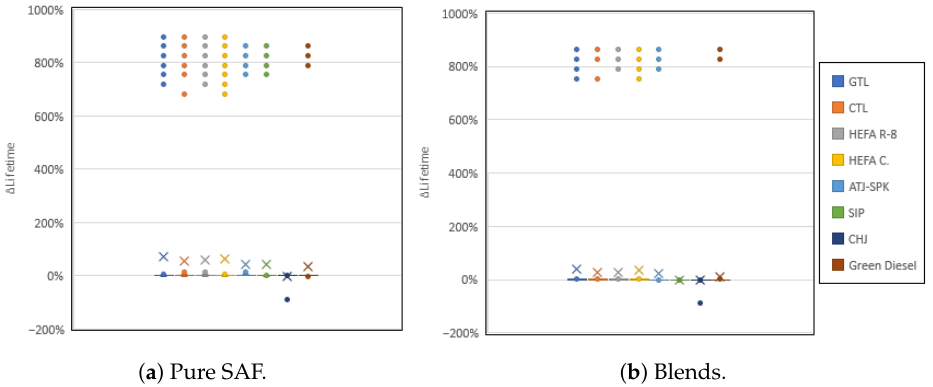
Figure 9. RDs in lifetime for reference contrails aged 30 min or